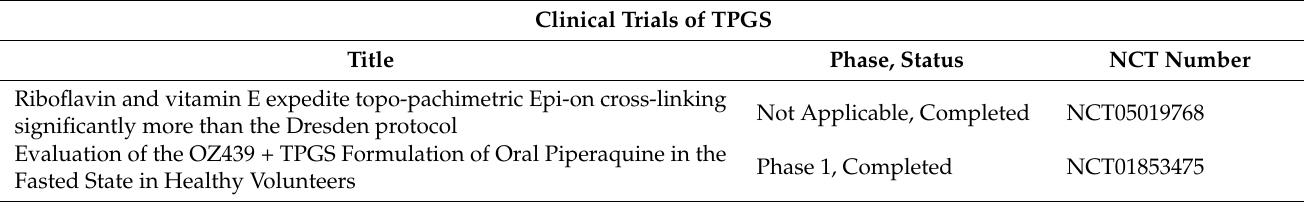
Table 3. Clinical trials of TPGS and its